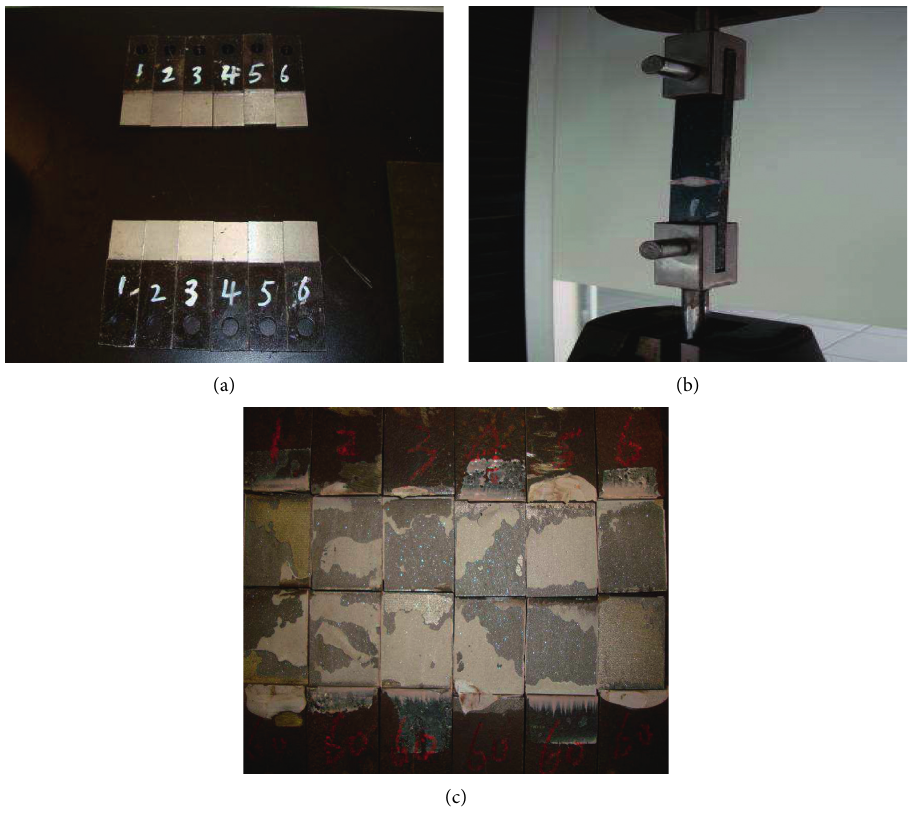
Figure 7: Lap shear test. (a) Specimen preparation; (b) test setup; and (c) failed specimens after test.